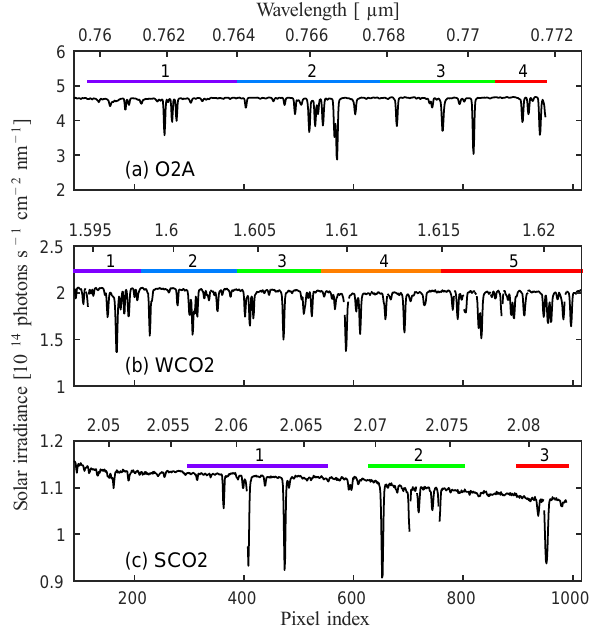
Figure 2. OCO-2 solar spectra measured at O2A (a) , WCO2 (b) , and SCO2 (c) bands. The colored horizontal bars indicate the spec- tral windows within which ILS functions are fitted. The solar spec- tra are from footprint 1, orbit 3928, on 29 March 2015.